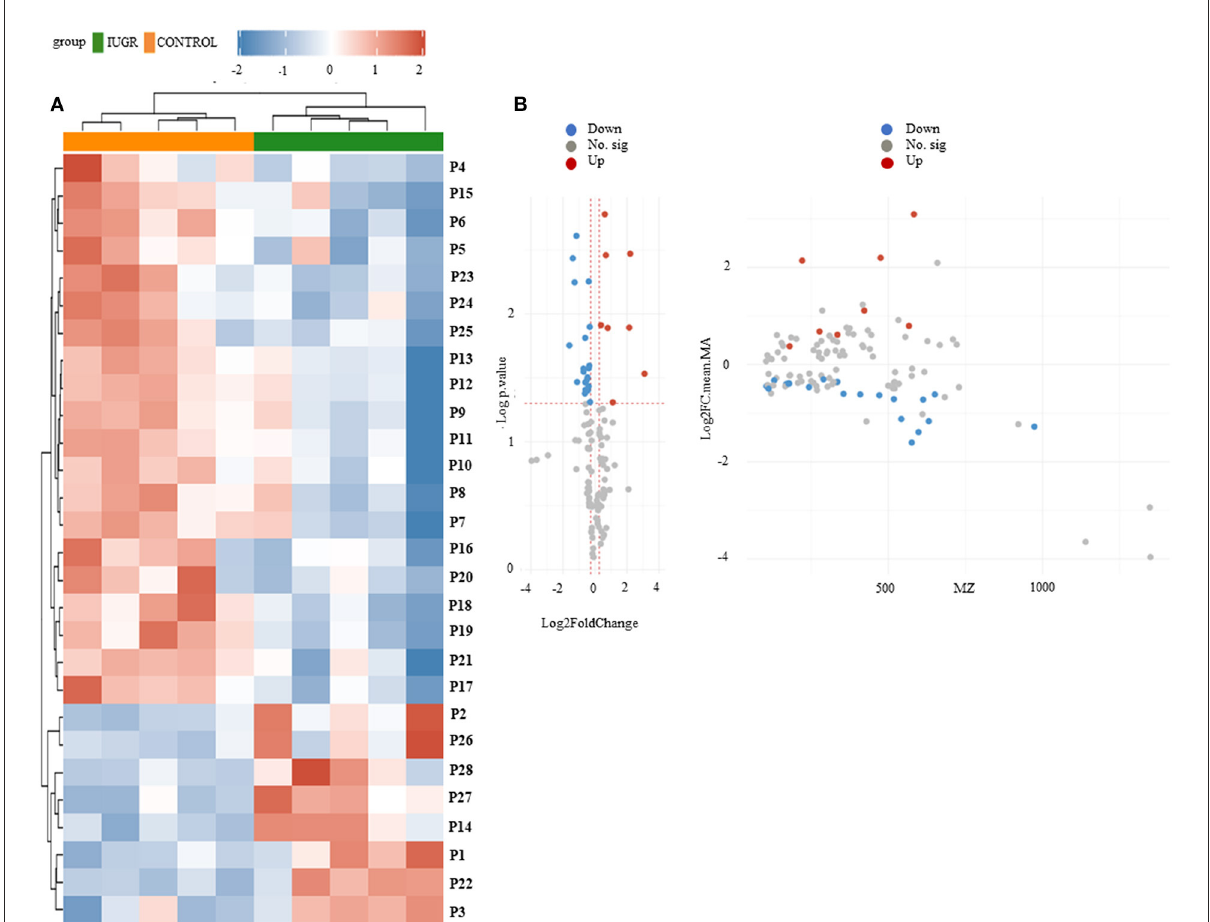
FIGURE4 (A) Hierarchical clustering analysis and heat map of control and IUGR rat lung tissue samples harvested on postnatal day 7. Color scale represents the scaled abundance of each variable, with red indicating high abundance and blue indicating low abundance. Compounds represented in the heat map are numbered according to their peak numbers ( n = 5). (B) Volcano plots of ultraperformance liquid chromatography–mass spectrometry (MS)/MS datasets. The y-axis represents p value converted to –log [ p value] and the x-axis represents log 2 [fold change]. Significant metabolites (fold change < 1.2, p value < 0.05) were highlighted in blue and red. Gray points represent non-significant